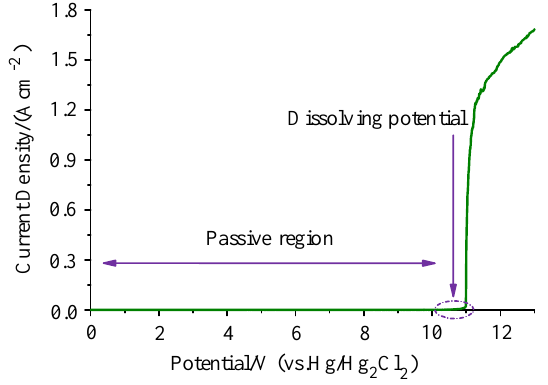
( b ) Figure 5. ECMG of the cathode tool: ( a ) in rough machining, ( b ) in finish machining. The test material was Ti6Al4V titanium alloy (mass fraction ratio Ti: 89.335%, Al: 6%, V: 4%, Fe: 0.3%, O: 0.2%, C: 0.1%, N: 0.05%, H: 0.015%). In order to select reasonable ECMG parameters, an electrochemical workstation (Zennium E, ZAHNER-elektrik GmbH & Co.KG, Kronach, Germany) was used to measure the anodic polarization curve of Ti6Al4V. The platinum electrode was used as a counter electrode and the calomel electrode was employed as the reference electrode. Polarization measurements were performed in 10% NaNO 3 solution at 30 ± 1 °C with a scan rate of 10 mV/s and a scan range of 0 to 13 V. The measurement results of the polarization curve of Ti6Al4V in 10% NaNO 3 solution are shown in Figure 6. It can be seen that when the temperature of the electrolyte solution was 30 °C, the dissolving potential of Ti6Al4V was about 11 V. In the passive region, the current density value was